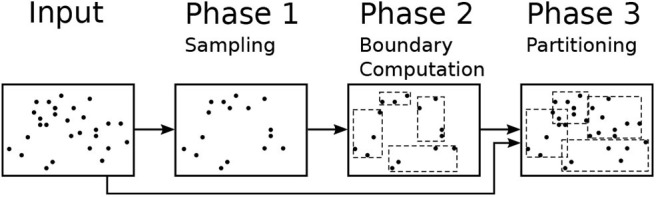
The sampling-based partitioning process.